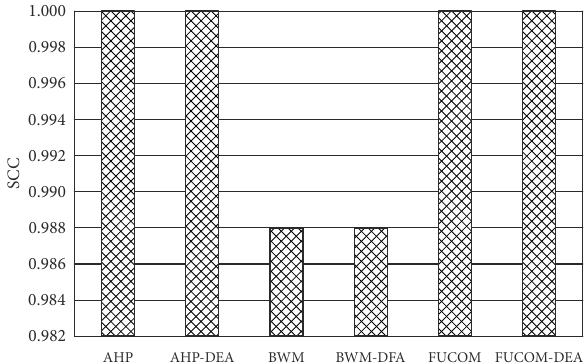
Figure 22. Rank correlataion of model testing